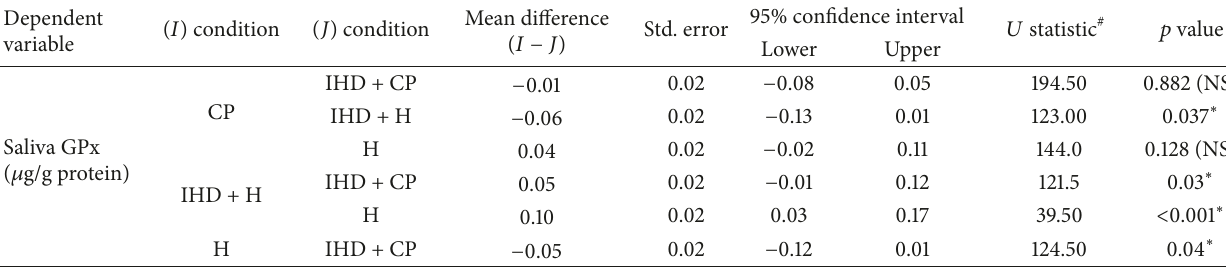
Table 4: Pairwise comparison using Mann–Whitney 𝑈 test.